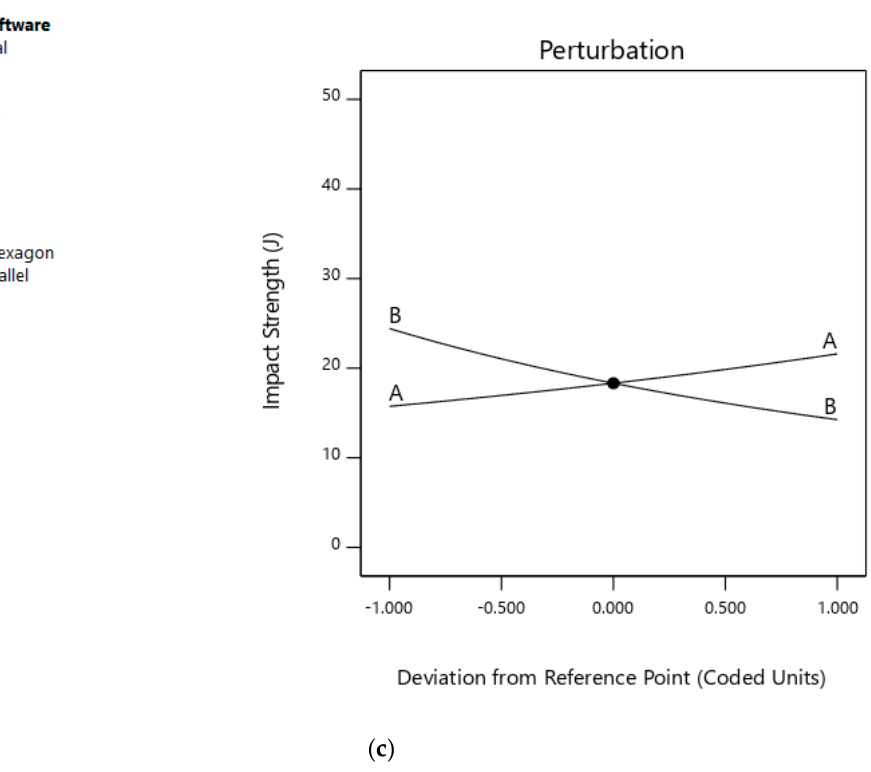
Figure 4. The influence of the process parameter for the ( a ) stripes scanning strategy, ( b ) chessboard strategy, and ( c ) hexagonal scanning strategy.